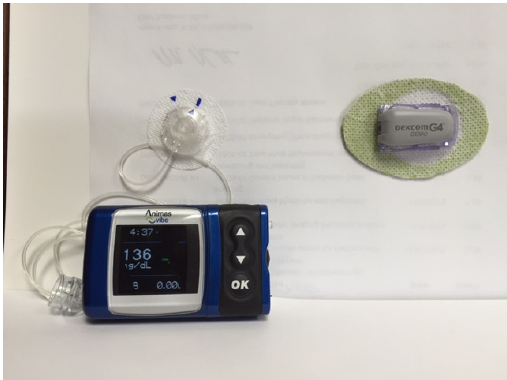
Figure 7. The Dexcom G4 Continuous Glucose Monitoring System ( left ) displays readings and graph on the screen of the Animas Vibe Insulin Pump.